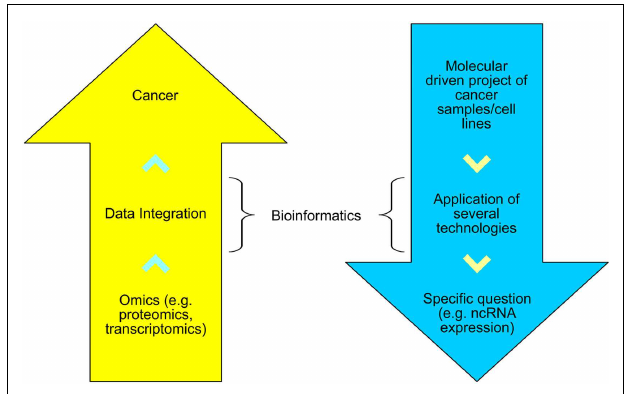
FIGURE 1 |The disease-oriented and methodological-driven types of research assisted by